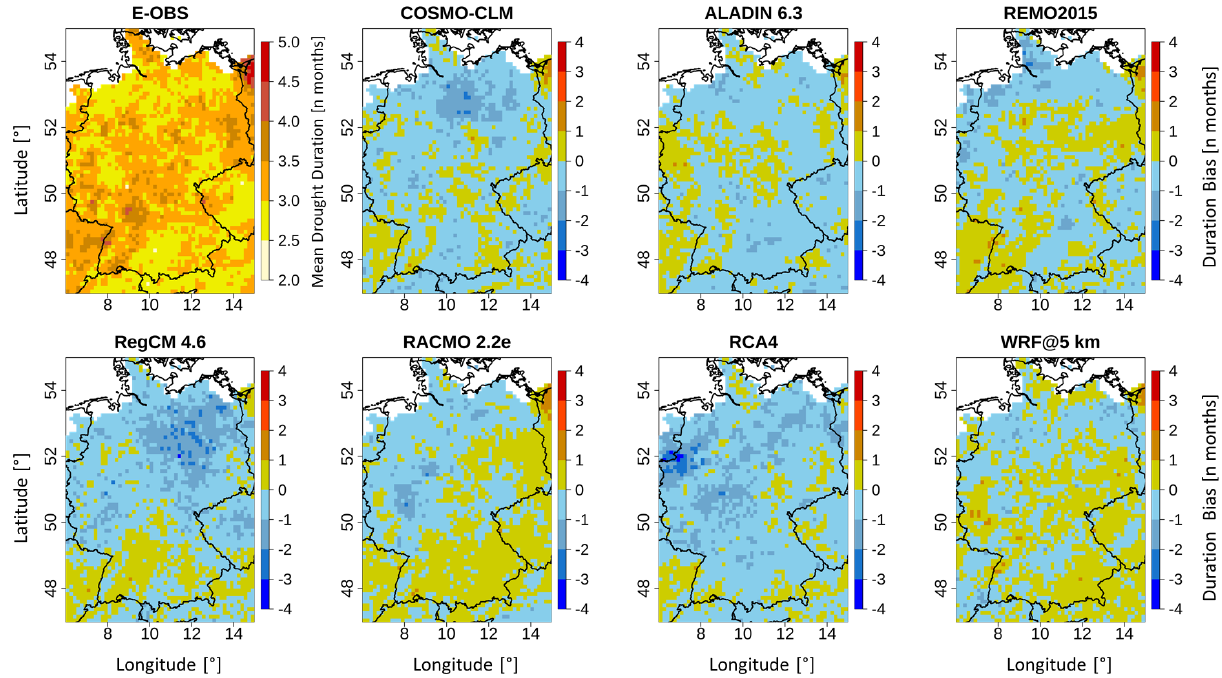
Figure 7. Grid-cell-based E-OBS mean drought duration pattern based on SPEI-3 between 1980–2009 and differences between each RCM and